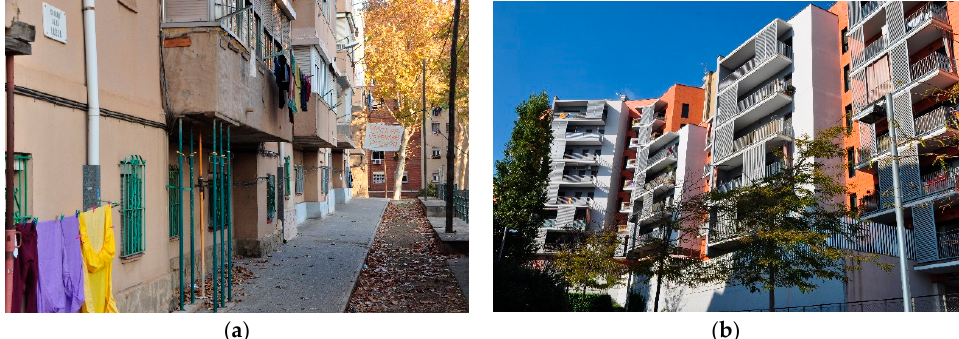
Figure 4. Trinitat Nova: ( a ) housing pending demolition, and ( b ) new homes.